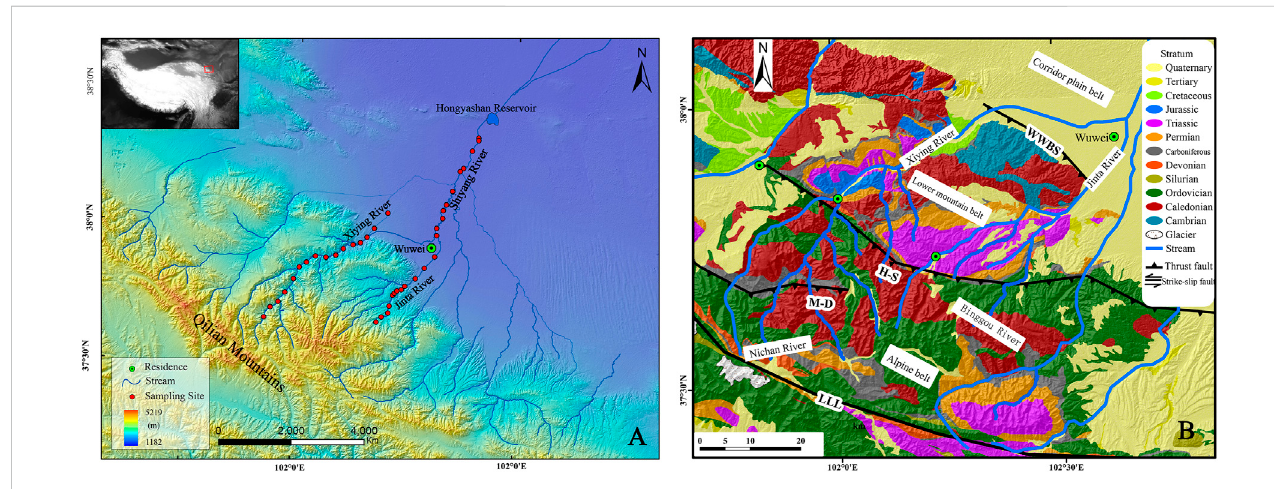
FIGURE 1 Location (A) and geological map (B) of the study area. Red dots of (A) indicate sample sites.